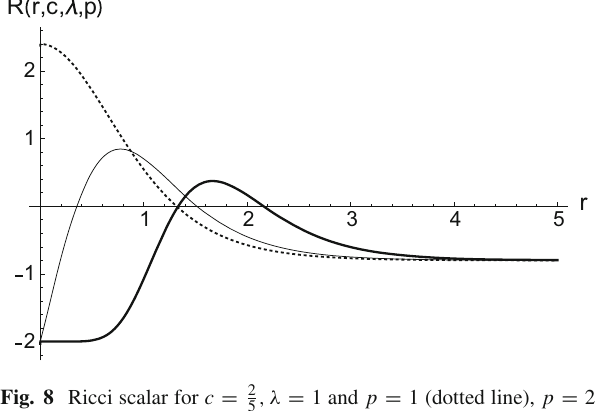
Fig. 6 Energy density (thick line), radial pressure (dotted line) and the angular pressure (thin line) for p = 6 and c = 2 λ